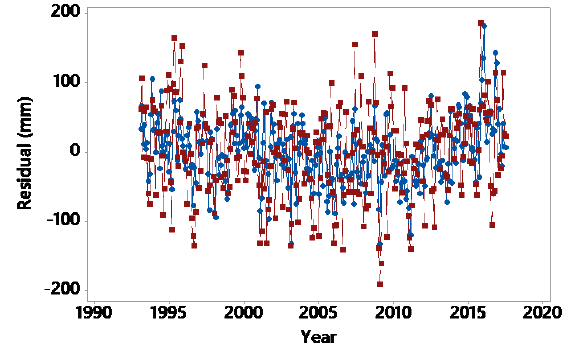
Fig. 3. Residuals of the SA (Blue) and TG